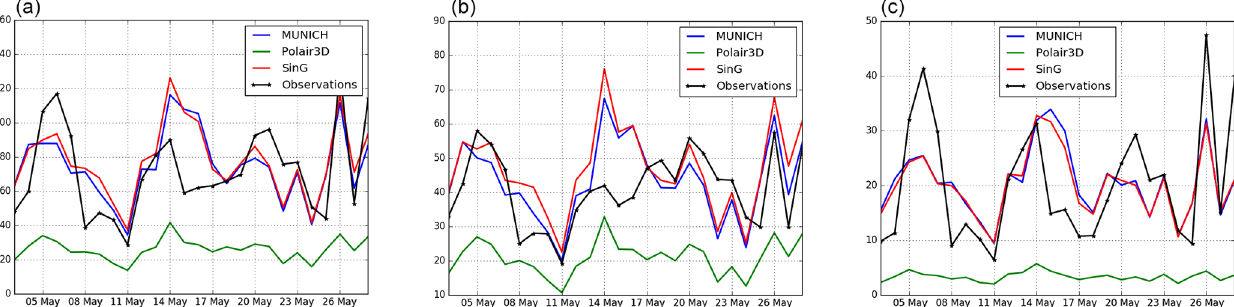
Figure 10. Daily average NO x (a) , NO 2 (b) and NO (c) concentrations (µgm − 3 ) observed and simulated at SOULT station with MUNICH, SinG and